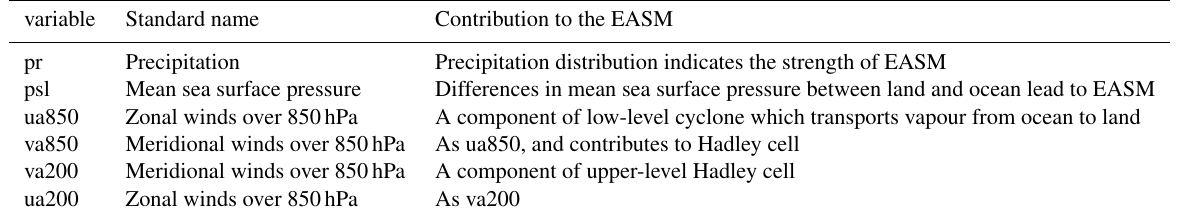
Figure 1. Anomaly correlation coefficient of six variables (i.e. precipitation, mean sea level pressure, and winds over 850 and 200hPa) between multi-model ensemble mean and observations in non-initialisation and initialisation. The green dotted grids illustrate the significance level at 0.05. The number in the lower left corner indicates the ratio of significant grid points to entire grids. The GPCP is employed as the reference data for precipitation (pr), while winds (i.e. ua850, va850, ua200, and va200) and mean sea level pressure (psl) are compared with ERA-Interim reanalysis. Table 3. Description of the six variables which contribute to the EASM. The abbreviation of these variables follows the guidelines of CMIP5. variable Standard